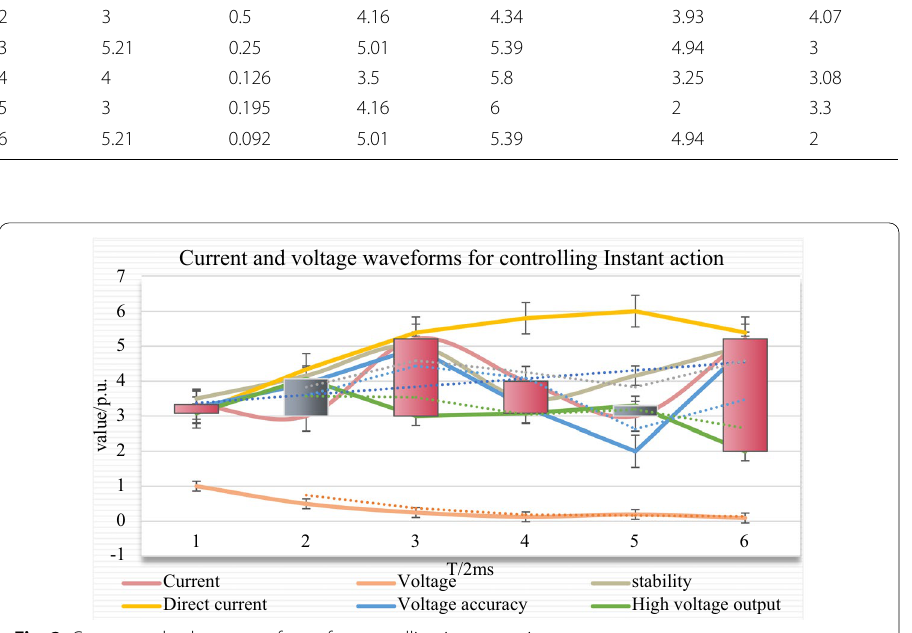
Fig. 2 Current and voltage waveforms for controlling instant